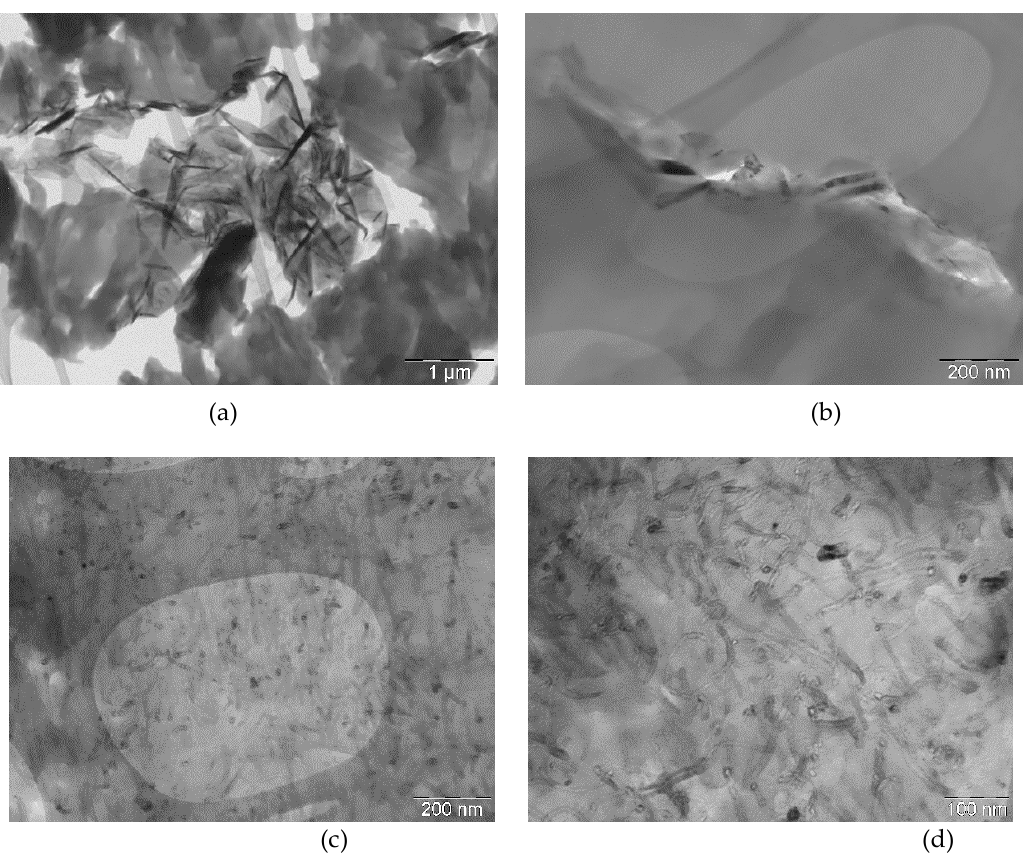
Figure 7. TEM micrographs of compression molded (CM) nanocomposites: ( a , b ) ABS/GNP and ( c , d ) ABS/CNT .